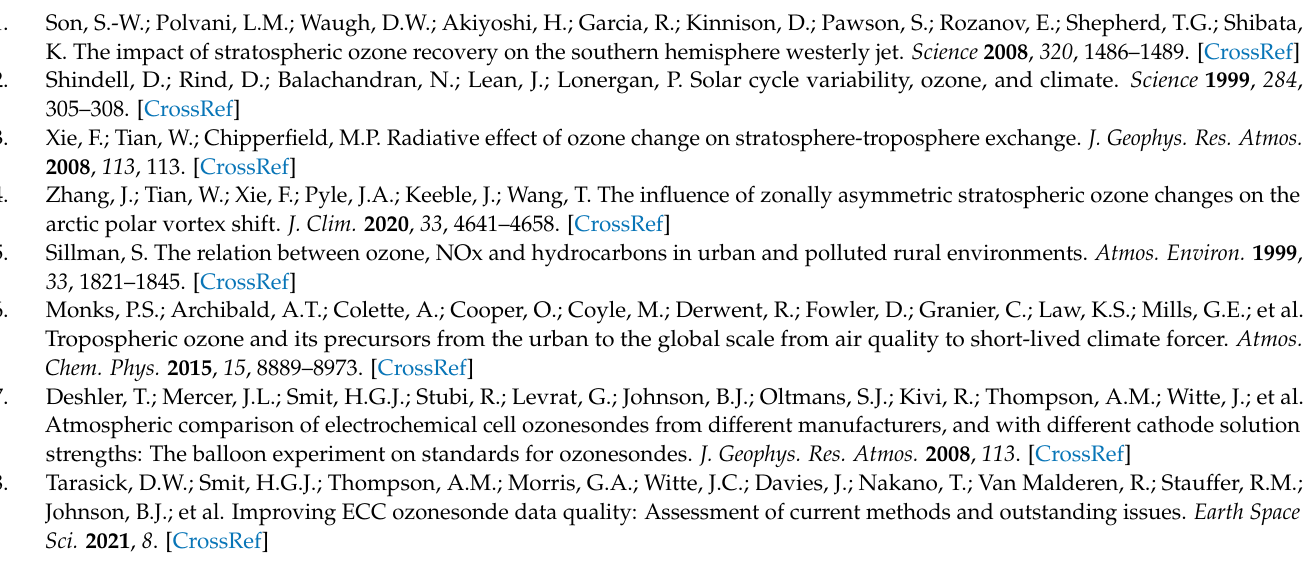
ground-based instruments) at Eureka site, Figure S2: The comparison of total column ozone between matched CrIS/AIRS/ERA5 and ground-based instruments at VindeIn site. Upper row: the time series of total column ozone; Middle and bottom rows: inter-comparison scatter plots with each other, Figure S3: The time series of total column ozone (CrIS/AIRS/ERA5 and ground-based instruments) at South Pole